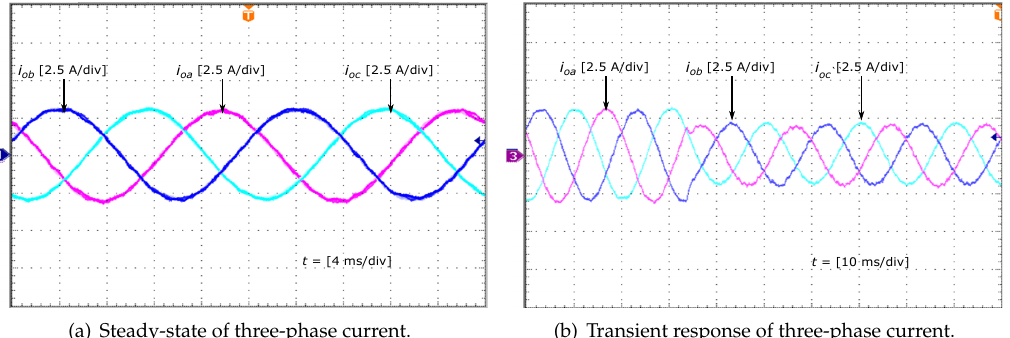
Figure 20. Execution time of the conventional and proposed methods.